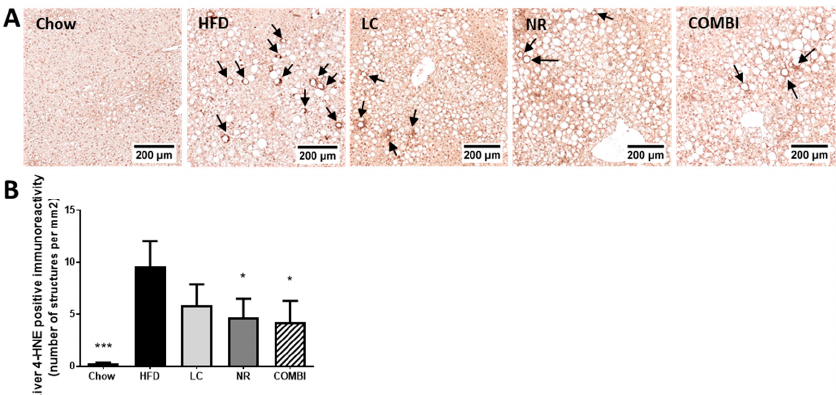
Figure 4. The 4-hydroxynonenal (4-HNE) marker for oxidative stress-related lipid peroxidation was analyzed in the liver using immunohistochemistry after 21 weeks of LC, NR and COMBI treatment. Stained liver sections were used for ( A ) representative images of 4-HNE, and quantification of ( B ) 4-HNE-positive immunoreactivity indicated here by arrows per mm 2 . Data are presented as mean ± SEM, * p < 0.05 compared to the HFD control group.